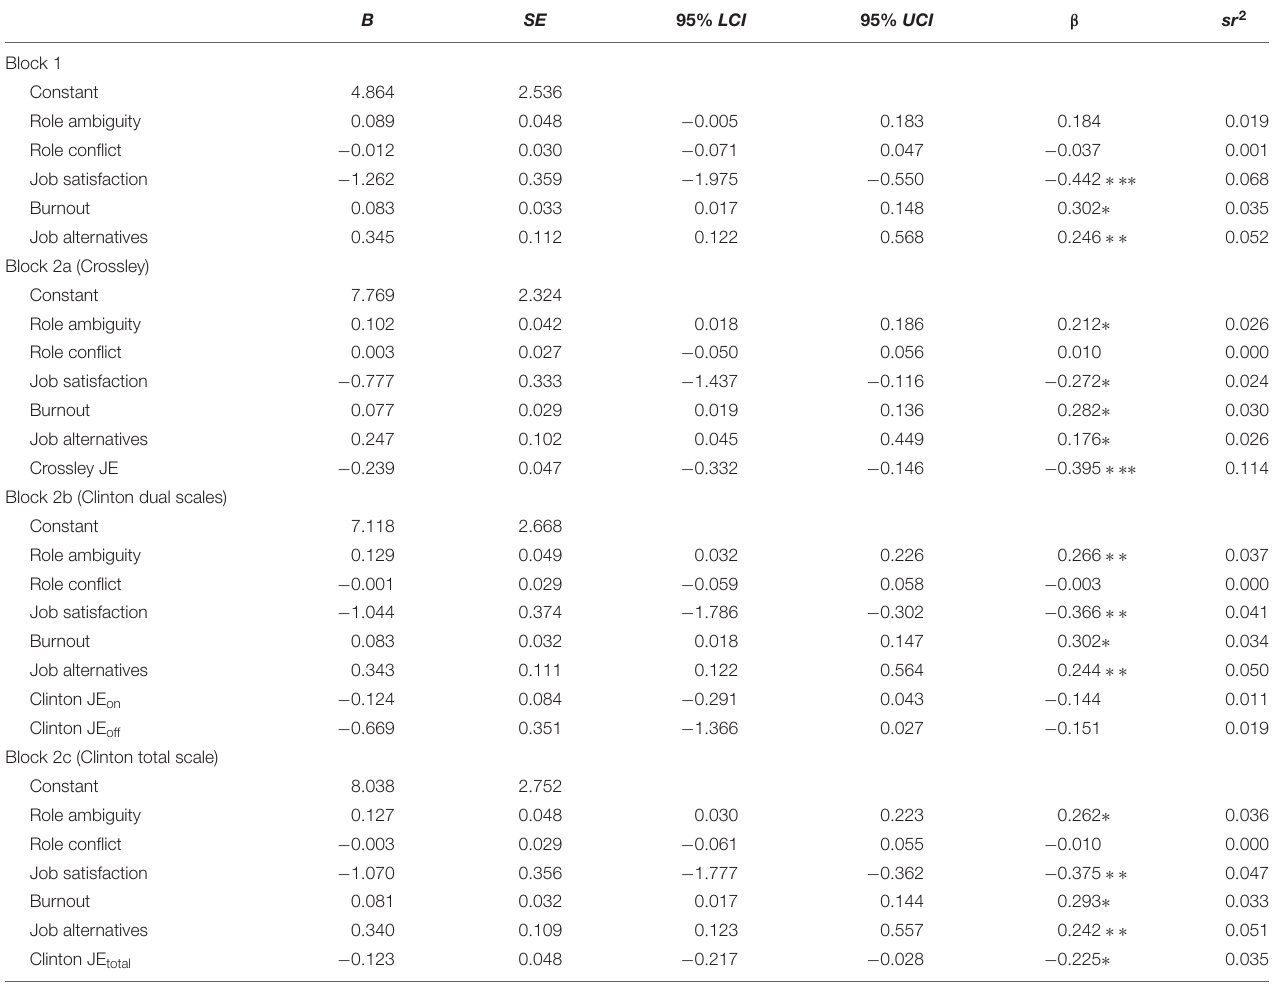
TABLE 3 | Predictor coefficients, significance, and confidence intervals of the models testing job embeddedness’ incremental validity for professional university staff ( N = 100). B SE 95% LCI 95% UCI